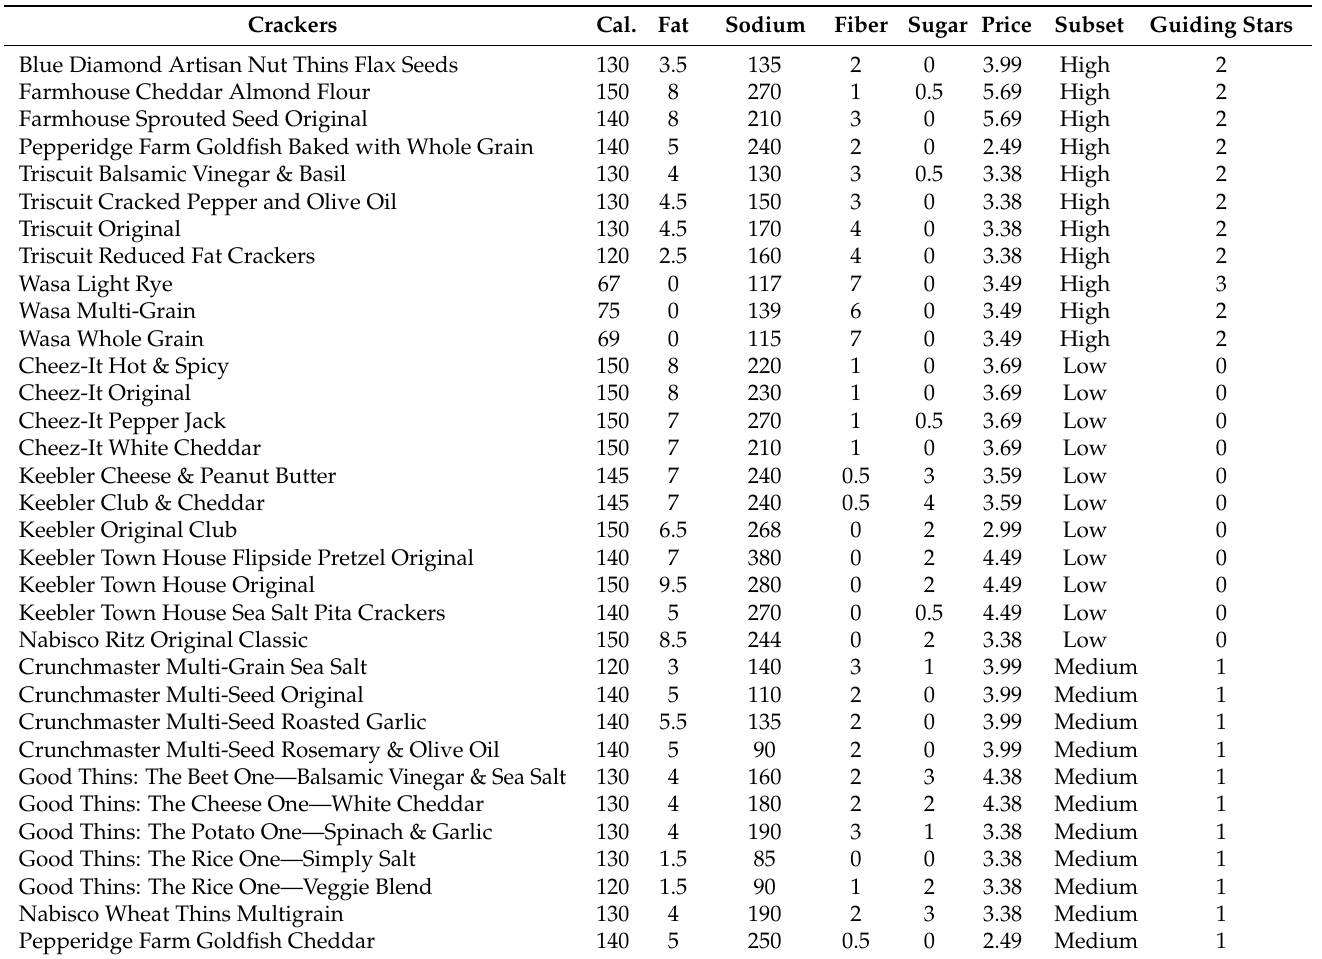
Table A3. Cracker products, nutritional and price information, and subsets in the